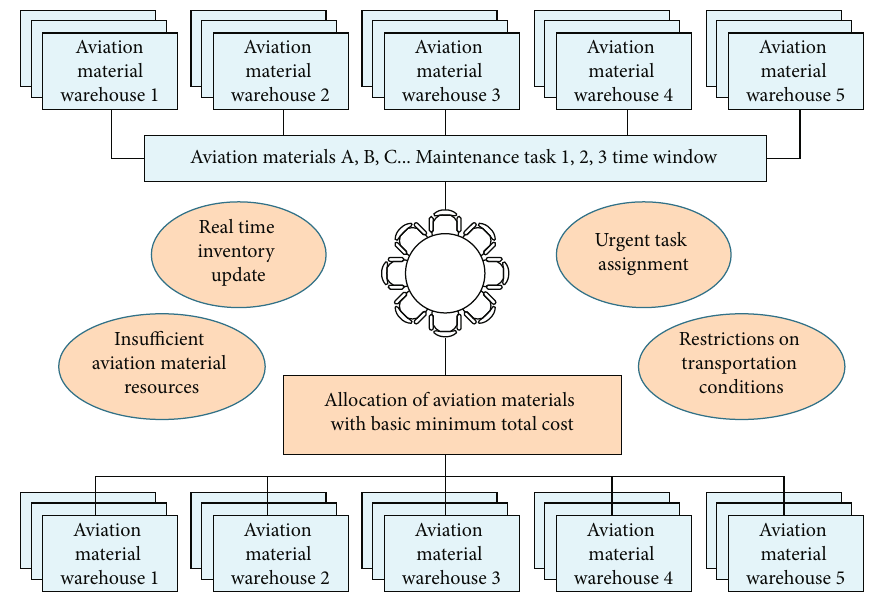
Figure 4: Schematic diagram of aviation material scheduling